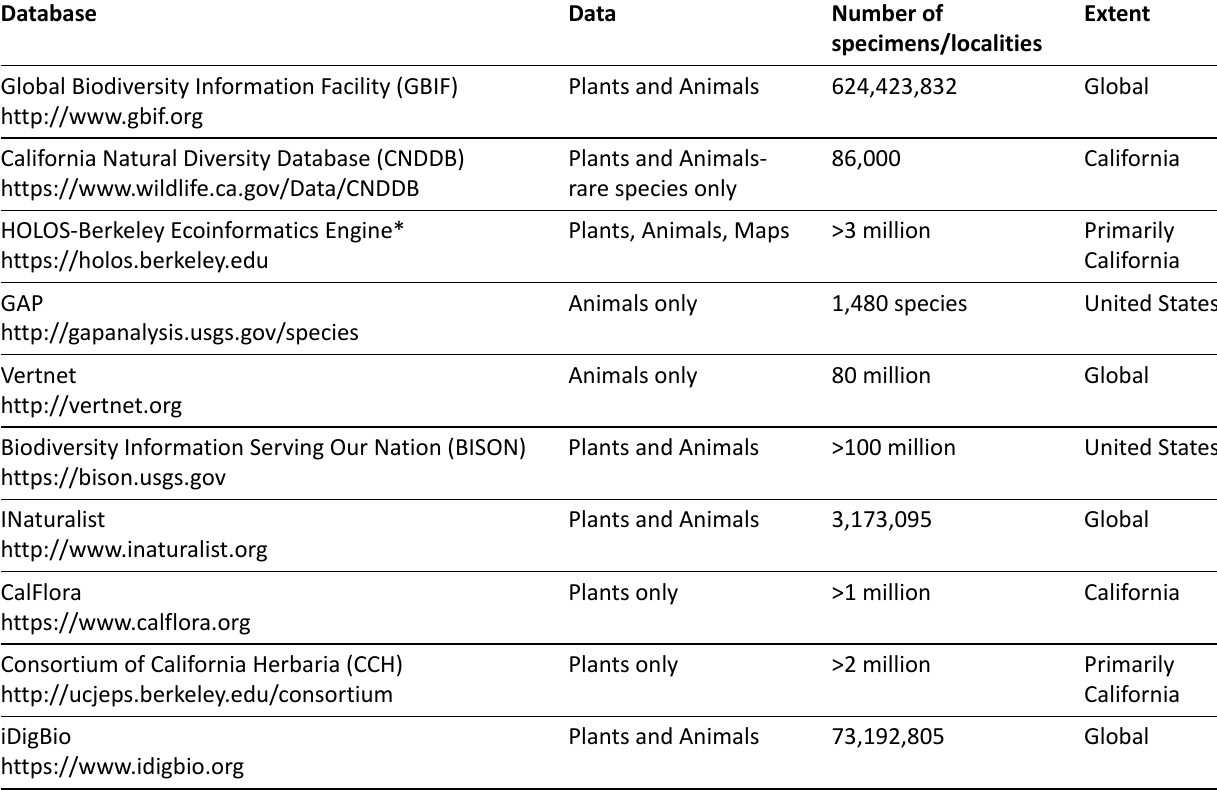
Table 4. List of the most comprehensive biodiversity databases for California with reference to the type of data they hold, the number of specimens reported at the time (11/2016) and their extent. These databases provide historical and current species occurrence information that can be used to construct species distribution models. Note that some records are redundant, and may be housed in multiple